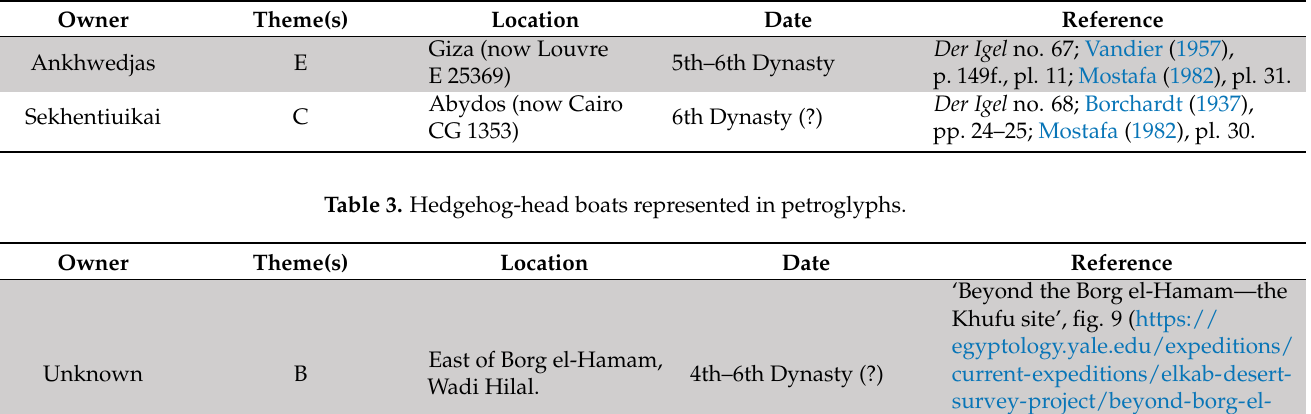
fig. 5. Note in this possible example that the head is not yet modelled.